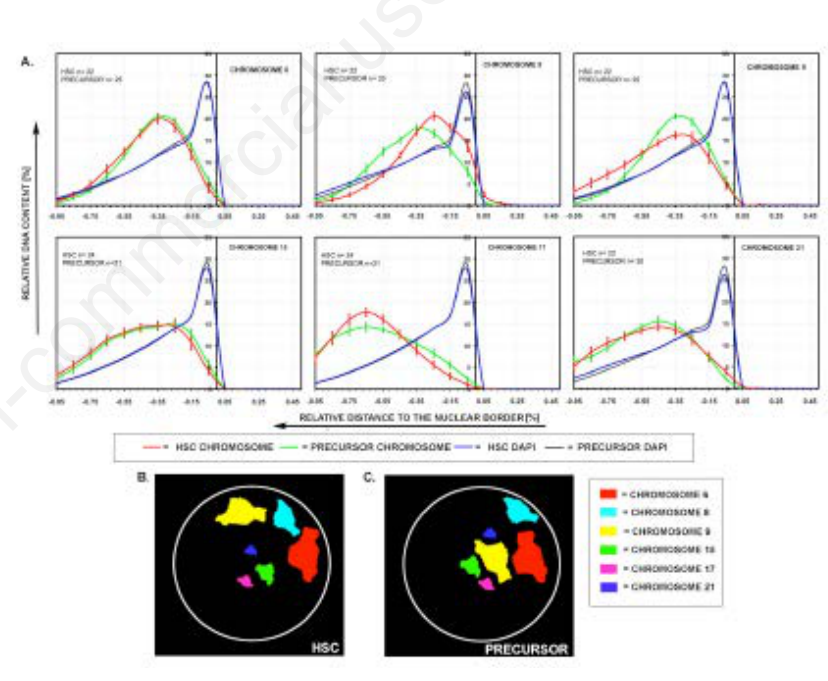
Figure 1. Quantitative 3D evaluation of the normalized localization of chromosome pairs 6, 8, 9, 15, 17 and 21 in CD34+ HSCs and CD14- myeloid precursors (A.). The curves represent the quantitative evaluation of the radial probe distribution in the nucleus (n=number of nuclei). The y-axis reports the relative DNA content as the normalized sum of voxel intensities for the fluorochrome used for each CT, while in x-axis is shown the normalized distance to the nuclear border. Negative values indicate the nuclear inside while “0” the nuclear border. The green curve represent the distribution of the chromo- some in HSCs, the red curve the distribution of the chromosome in myeloid precursors, the blue curve indicates the HSCs nuclear counterstain and the grey curve the myeloid precursors counterstains. Reconstruction of the inferred map for the interphase localiza- tion of chromosomes 6, 8, 9, 15, 17, and 21 in hematopoietic stem cell (B.) and myeloid precursor nuclei (C.). Chromosome positions have been reconstructed from average dis- tance values from the nuclear border. As such, homologous are thus shown as a single